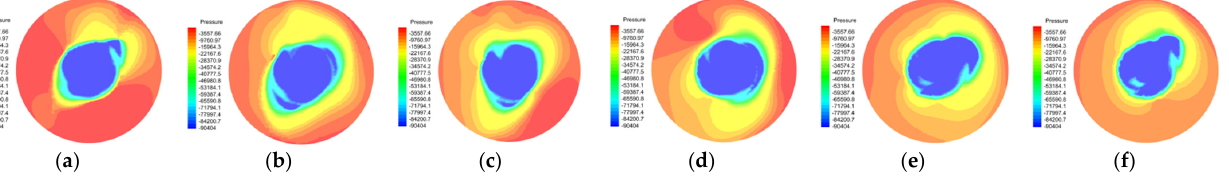
Figure 15. When inlet pressure = 15 MPa, gap = 1.5 mm, the variation of pressure of the original suction cup with time in vertical axial cross planes at: ( a ) 5 ms, ( b ) 9.4 ms, ( c ) 13.8 ms, ( d ) 18.2 ms, ( e ) 22.6 ms, and ( f ) 27 ms.